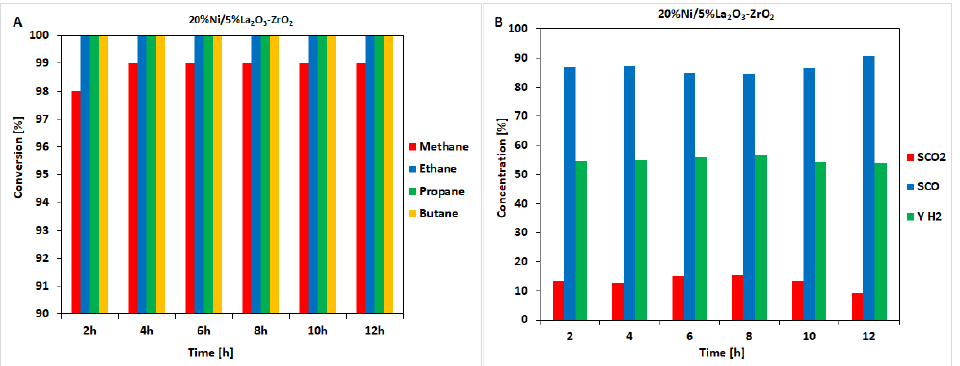
Figure 7. Results of the time-on-stream catalytic tests performed during 12 h of the OSRM of the LNG reaction on a 20%Ni / 5%La 2 O 3 -ZrO 2 catalyst. ( A ) Hydrocarbon conversion. ( B ) The selectivity of the CO and CO 2 and hydrogen yield.